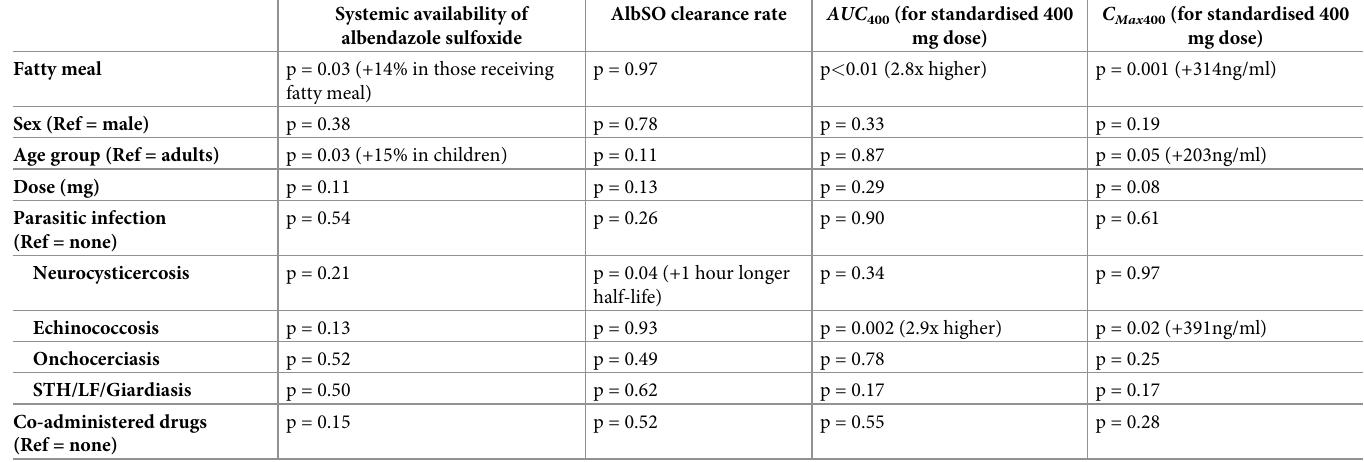
Table 1. Regression outputs (p-values) relating pharmacokinetic properties to patients’ characteristics. Inferred parameters from the fitted pharmacokinetic model, specifically the median values of albendazole sulfoxide (AlbSO) systemic availability, albendazole sulfoxide clearance rate, albendazole sulfoxide AUC 400 and C Max 400 were regressed onto various patient group demographic and treatment